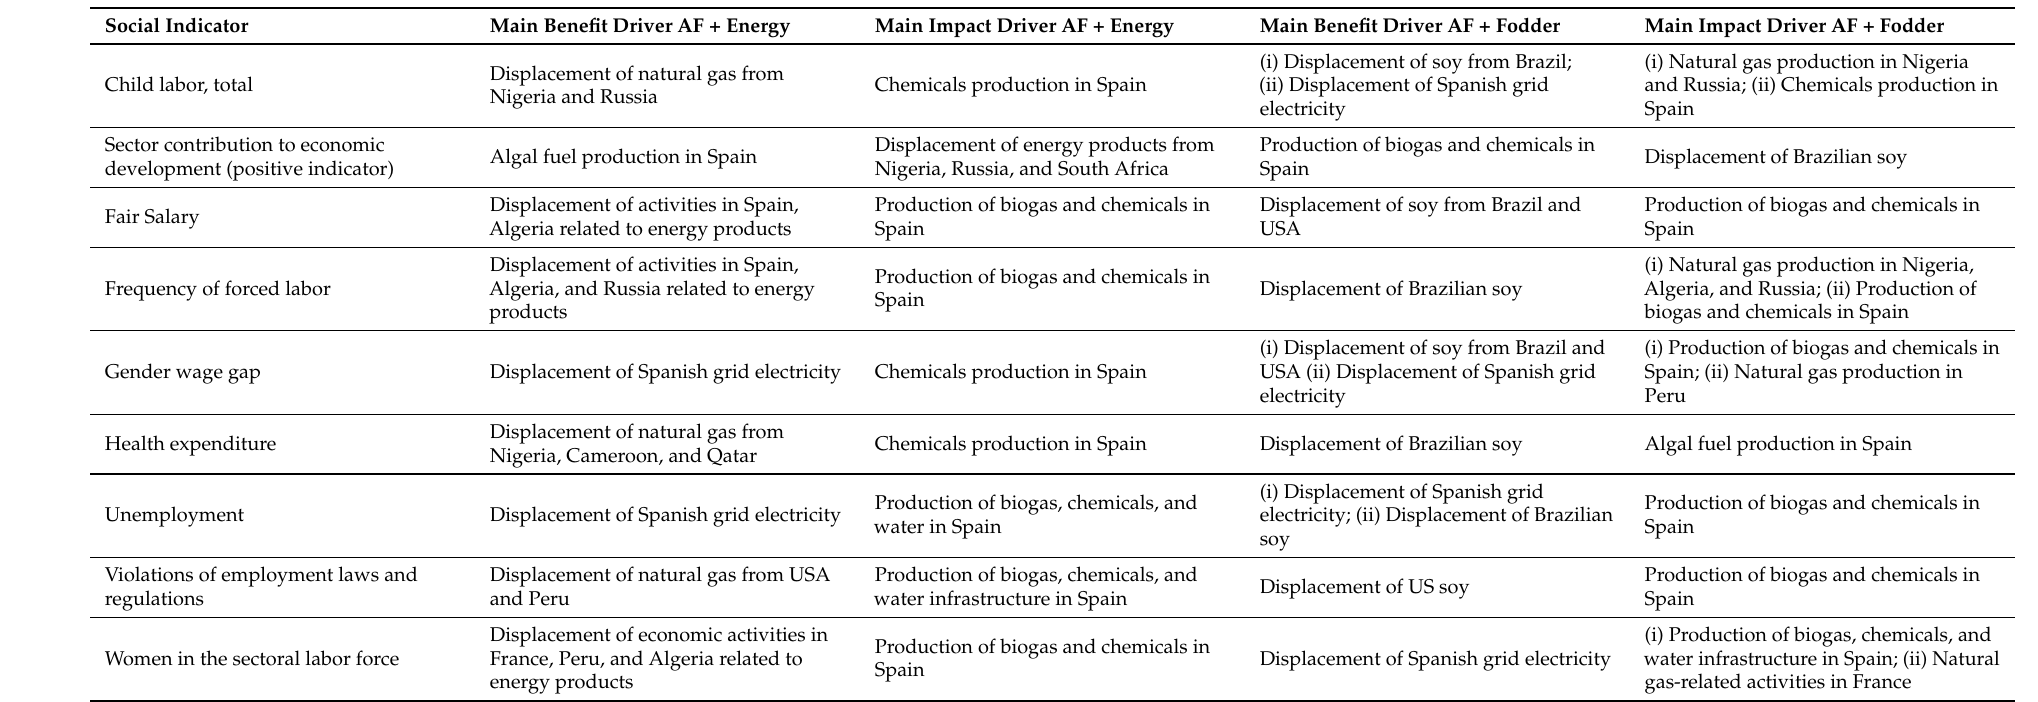
Table 3. Summary of social risk